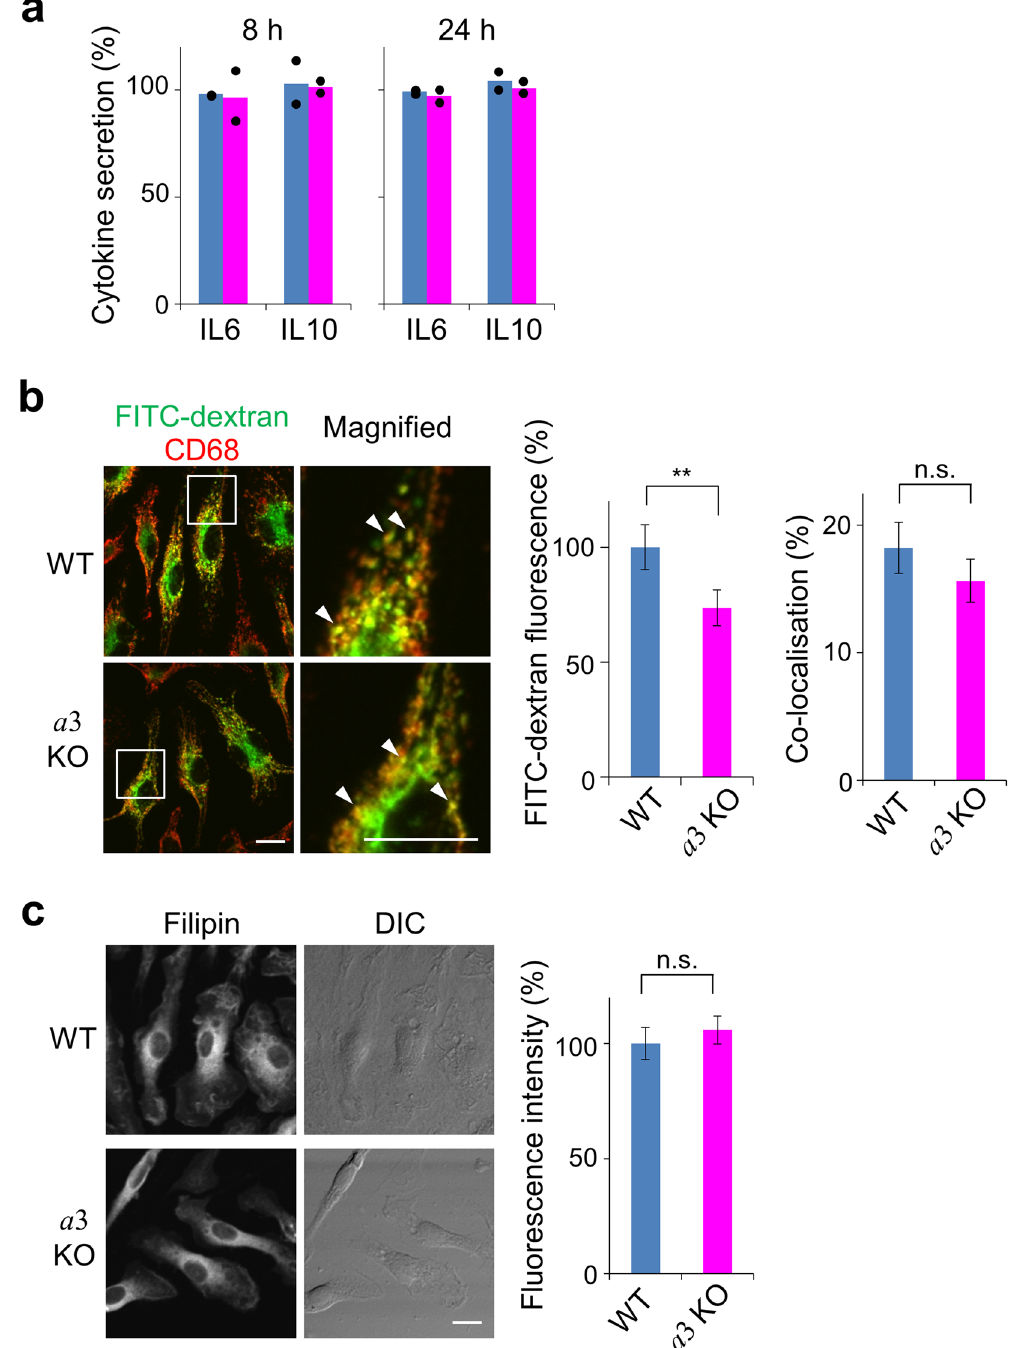
Figure 5. Cytokine secretion, endocytosis and cholesterol distribution in splenic macrophages. ( a ) IL6 and IL10 secretion by macrophages. Splenic macrophages from wild-type (blue) and a 3-knockout (magenta) mice were cultured with lipopolysaccharide for 8 or 24 h, and the levels of IL6 and IL10 were determined by ELISAs. Secretion was quantitated as the amount of cytokine secreted into the medium against the total amount of cytokine synthesised. The bars show the means of technical duplicates. The dots indicate independent values. The levels of synthesised cytokines differed by about 2-fold between wild-type and mutant macrophages. ( b ) Endocytosis of dextran in macrophages. Splenic macrophages from wild-type (WT) and a 3-knockout ( a 3KO) mice were incubated with FITC-dextran (green) for 30 min, washed and immunostained with an antibody against CD68 (red). FITC-dextran and CD68 were co-localised (Magnified, arrowheads). Bars indicate 10 μ m. The relative fluorescence intensities of FITC-dextran are shown, with that in wild-type cells set to 100% (middle panel). Data are means ± s.e.m.; ** p < 0.05 (unpaired two-tailed Student’s t -test); n = 131 wild-type and 170 mutant cells. Co- localisation of FITC-dextran and CD68 was determined as the percentage of FITC-positive pixels that were also CD68-positive (right panel). Data are means ± s.e.m.; n.s., not significant (unpaired two-tailed Student’s t